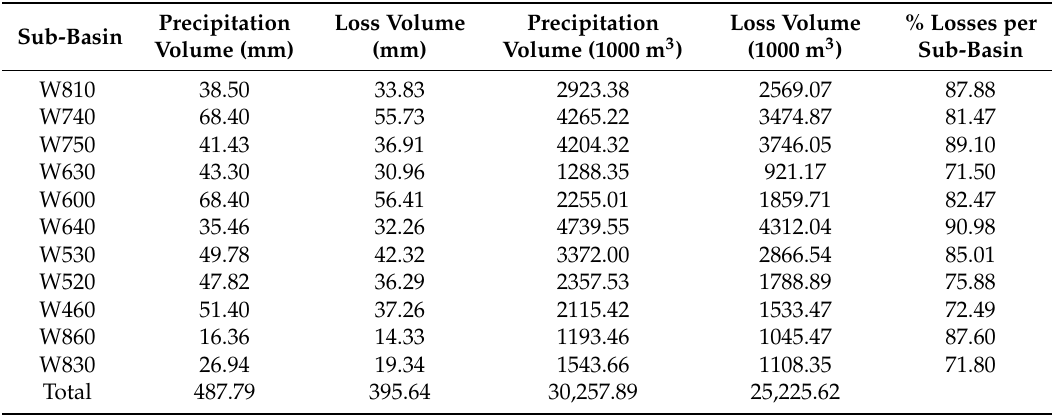
Table 12. Basin losses of